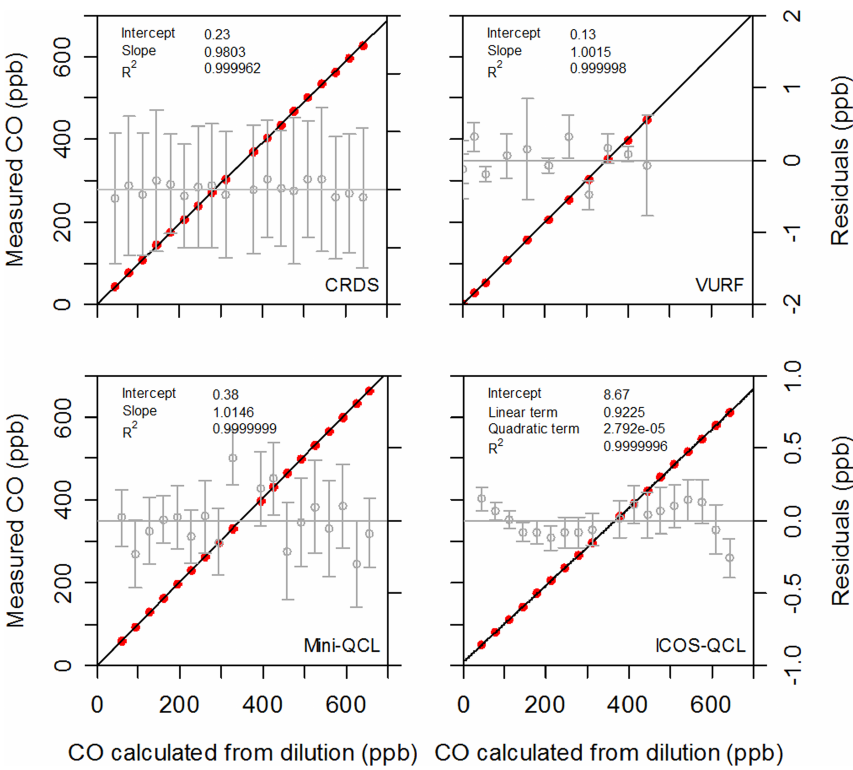
Fig. 6. Linearity plots for all instruments, including a fitted regression line and the regression residuals (open grey circles, right axis). Linear fits were applied for all techniques except ICOS-QCL (quadratic fit). Please take note of the different right-hand y-axis scales for the different